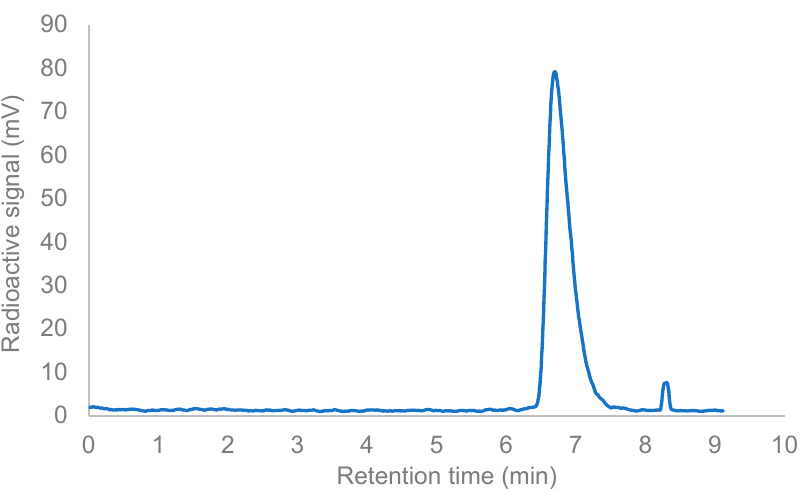
Figure 7. HPLC chromatogram of [ 133 La]La-mcp-M-PSMA (radioactive signal vs. retention time).